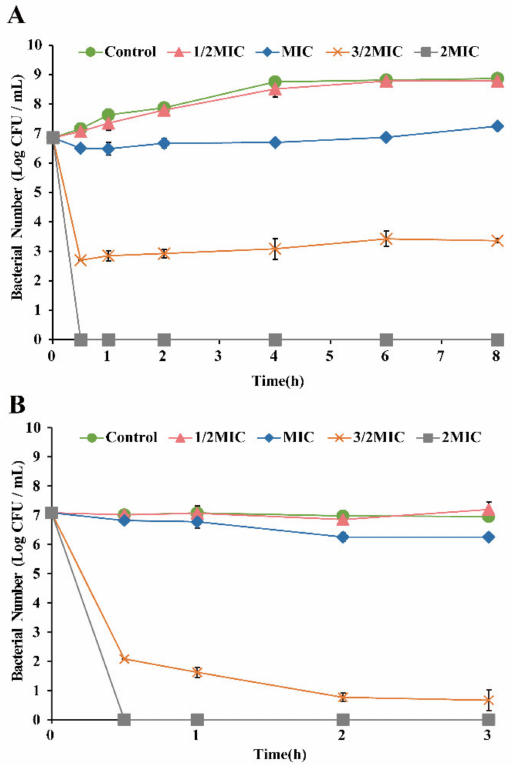
Figure 2. Effect of OEO on E. faecalis ATCC 29212 populations in BHI broth ( A ) and PBS ( B